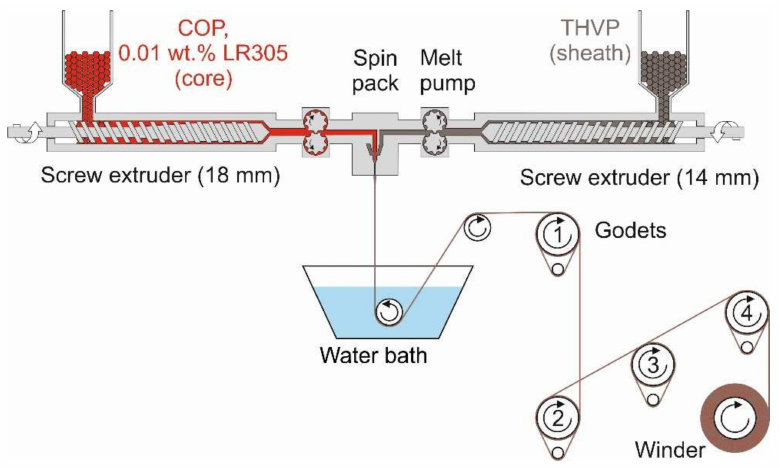
Figure 2. Schematic of pilot melt-spinning plant used to prepare PL-POFs. Previously dried COP (core material) was tumble-mixed with 0.01 wt% LR305 and fed into an 18 mm diameter extruder. The extruder encompassed three heating zones, which were set to 180, 265 and 270 ◦ C. The melt was then pumped into the spin pack at 10.5 cm 3 /min. The THVP (sheath material) was fed into a 14 mm extruder, which had three heating zones set to 100, 165 and 280 ◦ C. The melt was pumped into the spin pack at a rate of 6 cm 3 /min. The fibers were melt-spun into a water bath followed by a drawing over four godets in series (Table 1). Two different draw ratios (ratio between the winder and take-up godet 1 speeds in m/min) have been applied, namely DR = 1.1 and DR = 1.6.